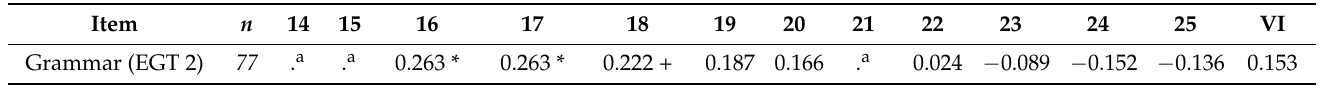
Table 2. Correlation ELIAS Grammar Test 2 (EGT 2) with single items and total score of TIOS Verbal Input Scale.